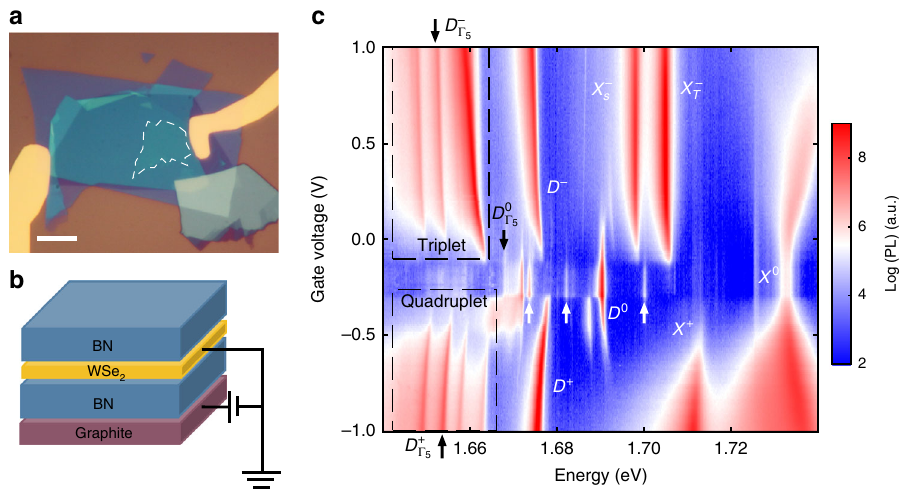
Fig. 1 Gate-dependent photoluminescence. a Optical image of a representative gated WSe 2 device, in which monolayer WSe 2 (white dashed line area) is encapsulated in hBN with a graphite local back gate, scale bar is 10 µ m. b Schematic of a gated WSe 2 device. c Photoluminescence (PL) as a function of back gate voltage and photon energy. Excitonic states which have been reported in the literature are identi fi ed and marked. X 0 : neutral exciton; X + : positive trion; X (cid:1) and X (cid:1) : intravalley and intervalley trion; D 0 : spin forbidden neutral dark exciton; D + : positive dark trion; D − negative dark trion. The unidenti fi ed S T triplet PL peaks at electron doping, quadruplet PL peaks at hole doping, and three states at the neutral regime, pointed to by the white arrows, are the focus of this